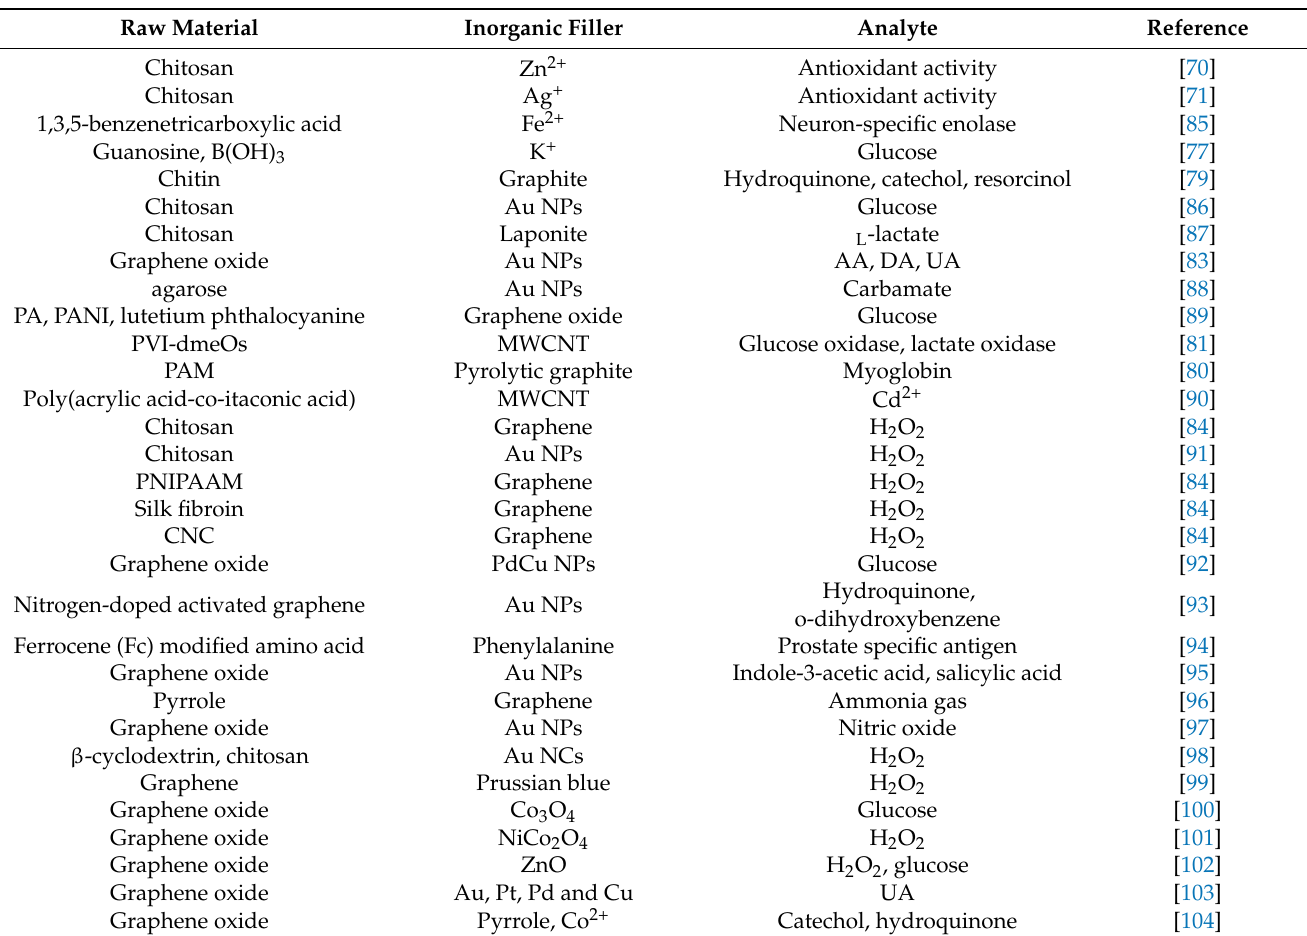
Table 1. Summary of inorganic material-filled hydrogel for electrochemical